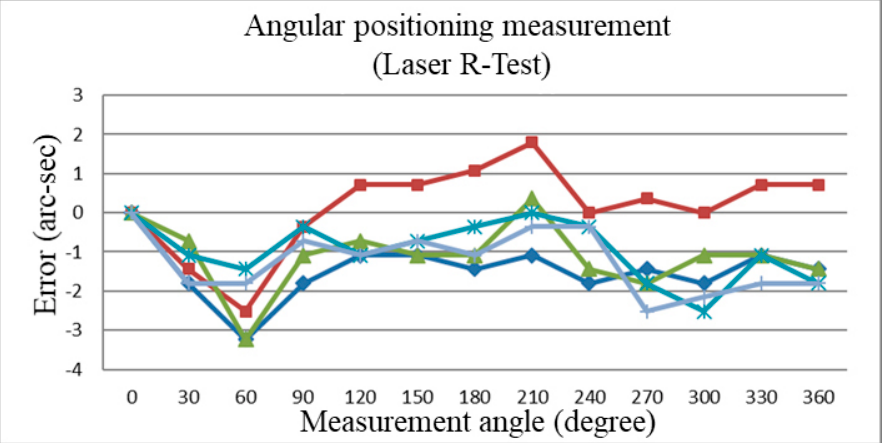
Figure 23. The angular positioning measurement (Laser R-test).